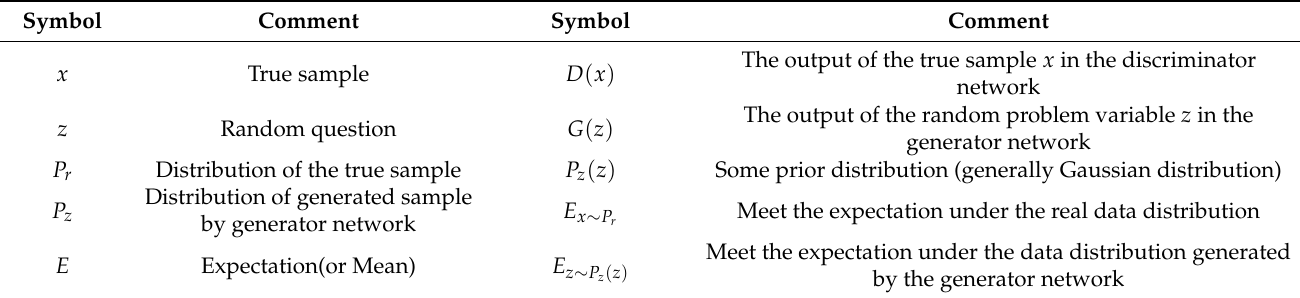
Figure 1. Flow chart of GAN. Table 1. Parameters in the mechanical model. Table 1. Parameters in the mechanical model.